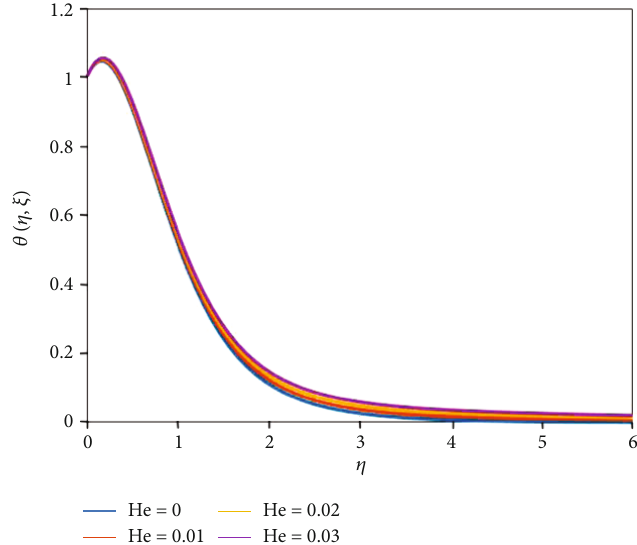
Figure 4: Velocity pro fi le for di ff erent values of M when λ = 0 : 1, N = 0 : 5, n = 0 : 5, f R